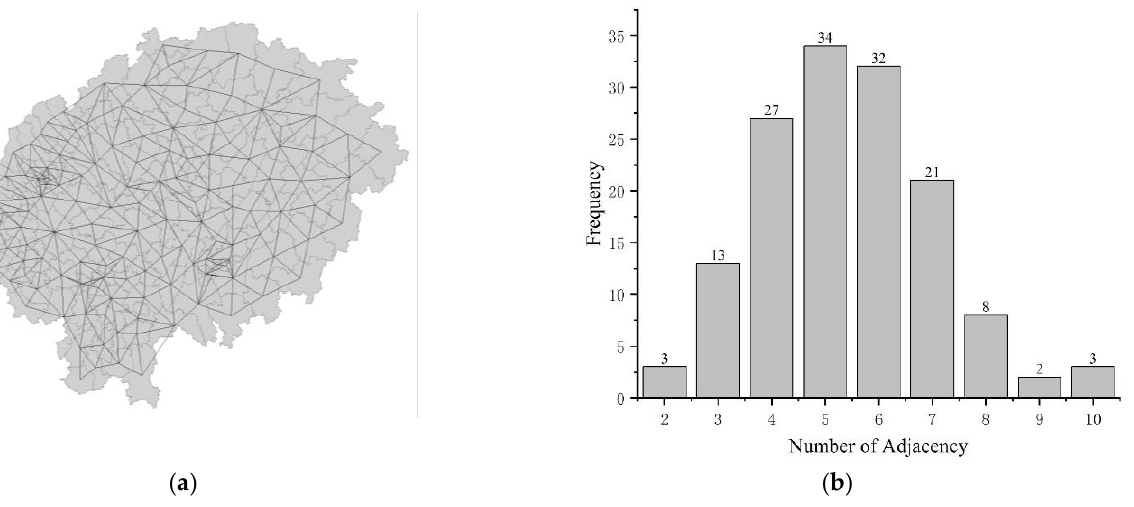
Figure 8. The adjacency matrix of the sample unit. ( a ) The connected graph of the adjacency matrix. ( b ) Neighborhood statistics for each sample unit.